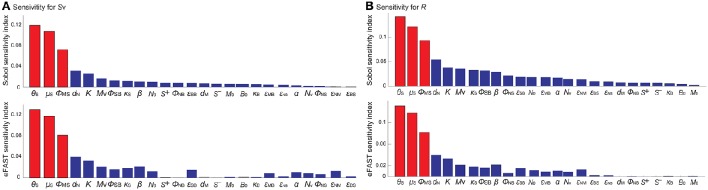
Global sensitivity analysis of the model with respect to (A)
Sv and (B)
R, using the SOBOL and eFAST sensitivity indices.